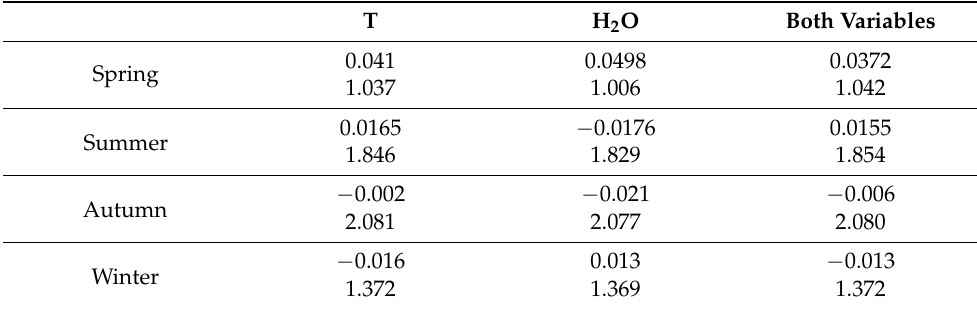
Table 4. Means and standard deviations of variations of CO 2 induced by variations of T (1–10 hPa: